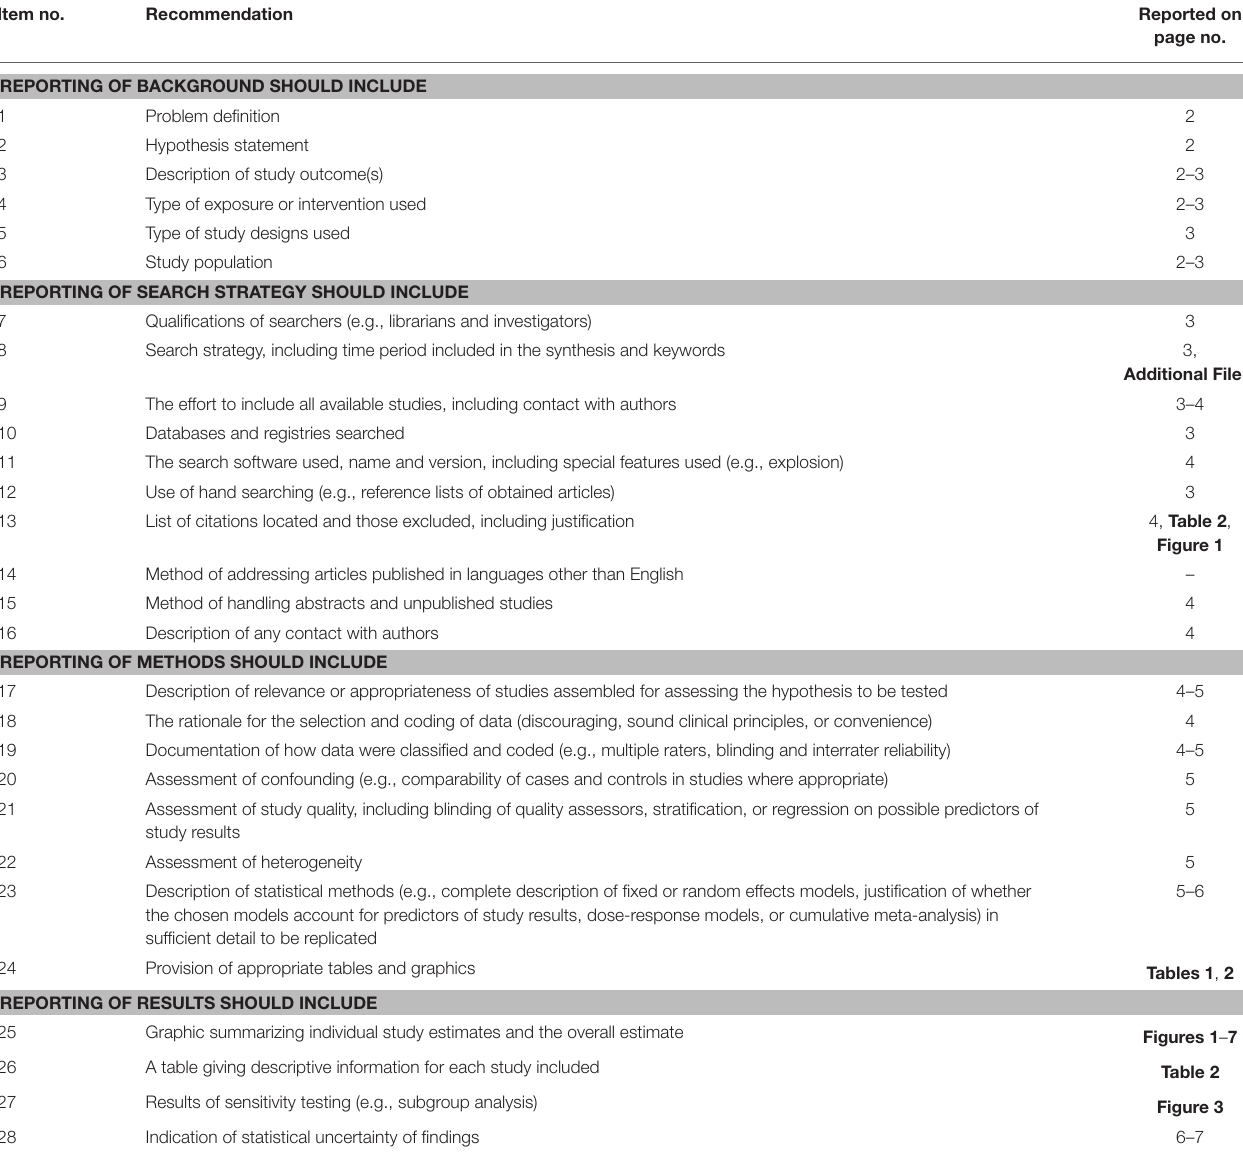
TABLE 1 | MOOSE checklist for meta-analyses of observational